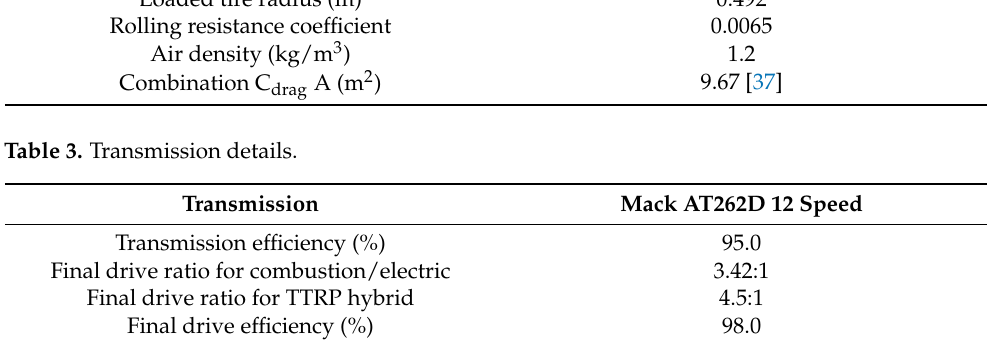
Table 3. Transmission details.